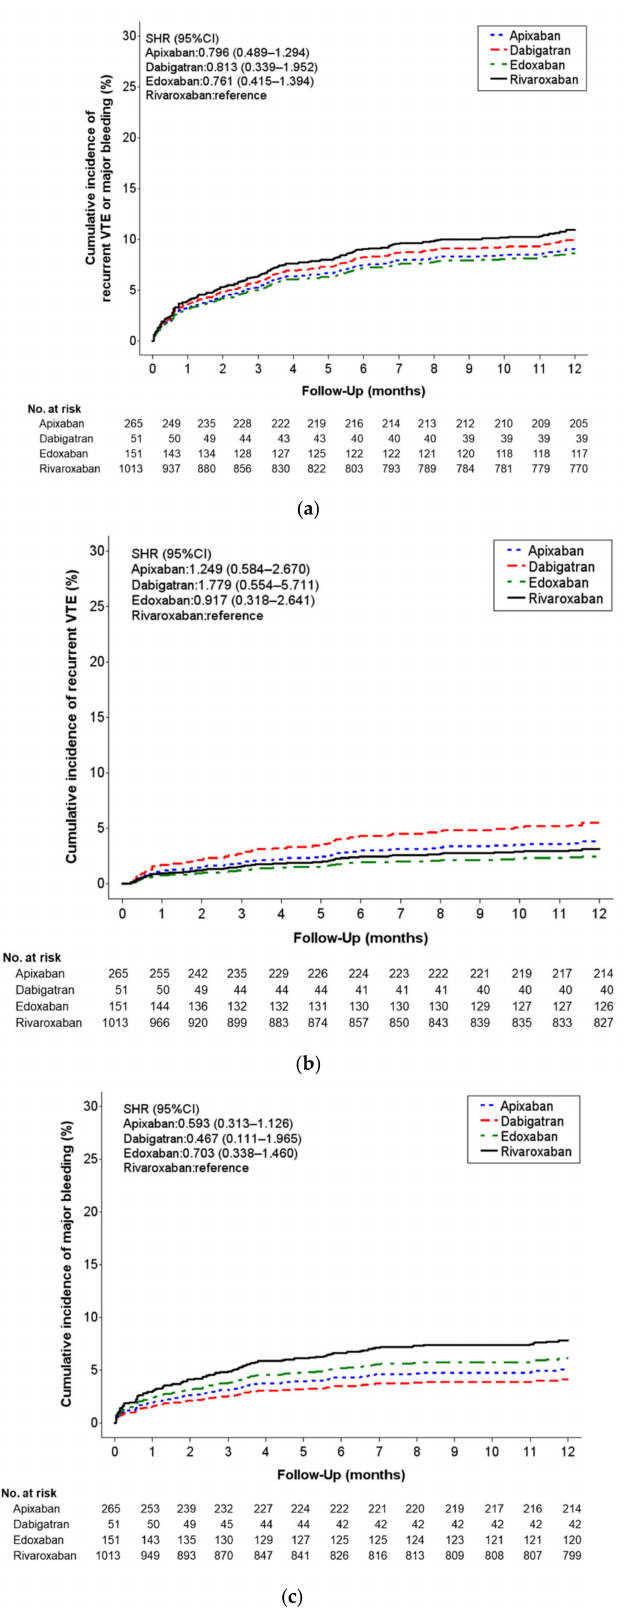
Figure 2. ( a ) Cumulative incidence of recurrent VTE or major bleeding at 1-year follow-up for each DOAC type. ( b ) Cumulative probability of event rates in each study group for recurrent VTE. ( c ) Cumulative probability of event rates in each study group for major